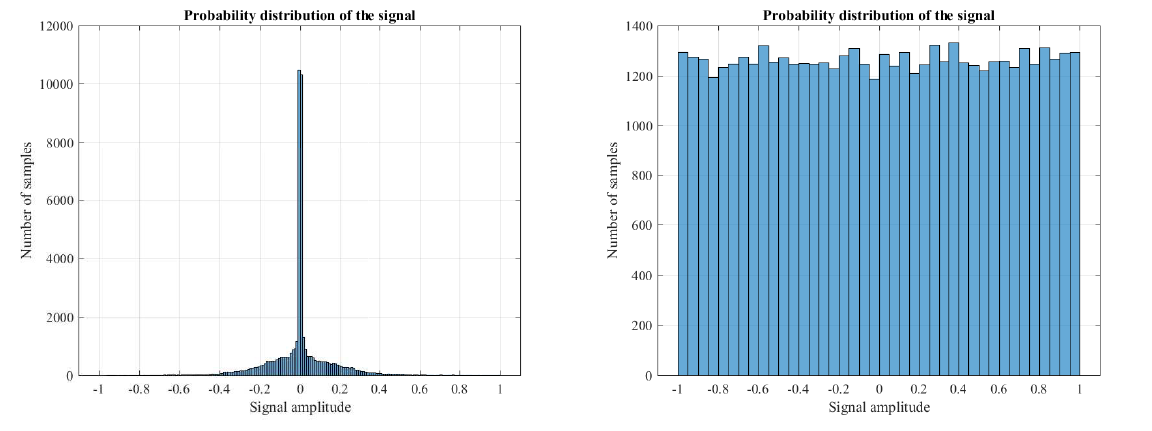
Figure 7. Histograms of plain file and encrypted